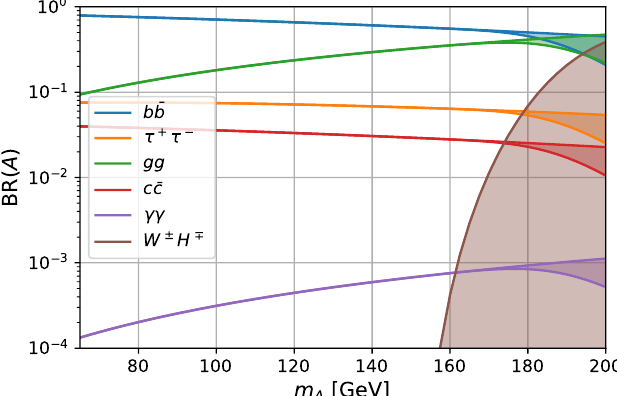
Figure 18. Branching ratios of A in the cH ( WA ) benchmark scenario as a function of m A . The decays A → γγ and A → W ± W ∓ additionally depend on m and induce a dependence in H ± the remaining BRs through the total width. The bands for each BR indicate the impact of this dependence for 150 GeV < m < 300 GeV H ±